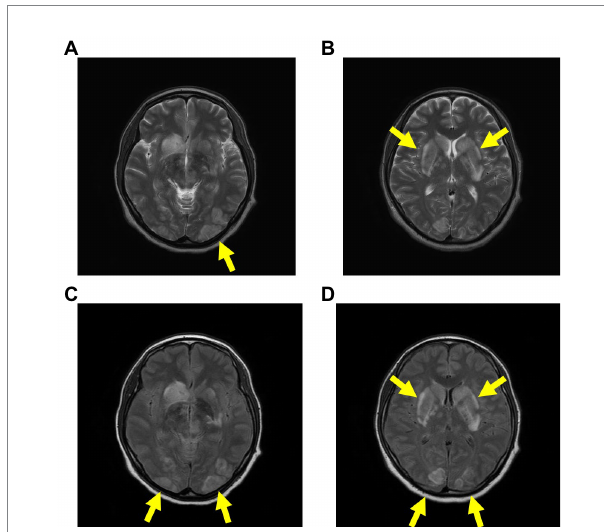
FIGURE 2 Head MRI on admission. The head MRI reveals caudate nucleus hemorrhage and PRES, with hyperintense signals on T2 (A,B) and FLAIR (C,D) sequences in the bilateral occipital regions, caudate nucleus, and putamen. Abbreviations: MRI, magnetic resonance imaging; PRES, posterior reversible encephalopathy syndrome; FLAIR, fluid-attenuated inversion